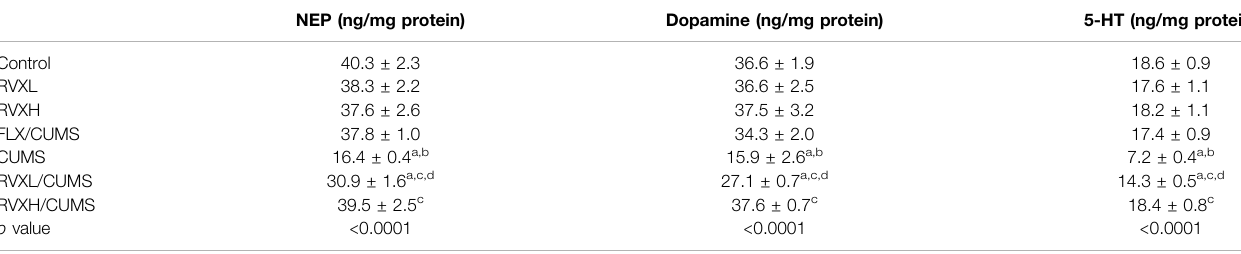
TABLE 1 | Effect of RVX at different doses on hypothalamic neurotransmitters levels. NEP (ng/mg protein) Dopamine (ng/mg protein)